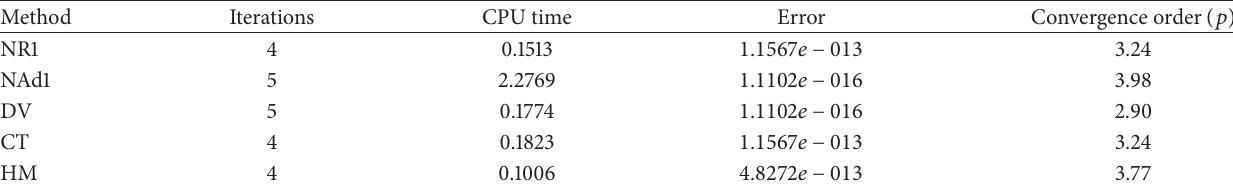
Table 8: Numerical results of Example 6 for dimensions 𝑛 = 512 .